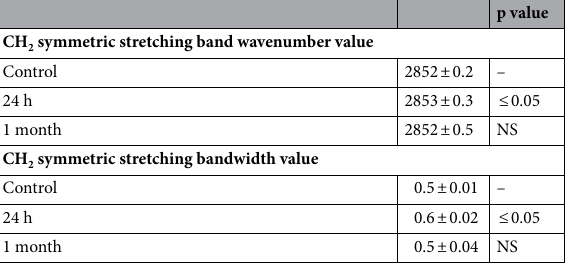
Table 2. The wavenumber and bandwidth values of CH 2 symmetric stretching band of control, 24 h and 1 month rat